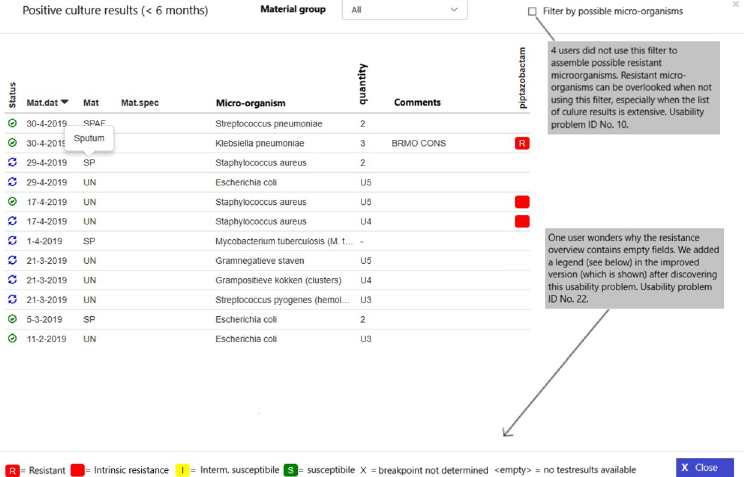
Fig 3. The resistance viewer in the CDSS for empirical antibiotic therapy and illustration of 2 usability